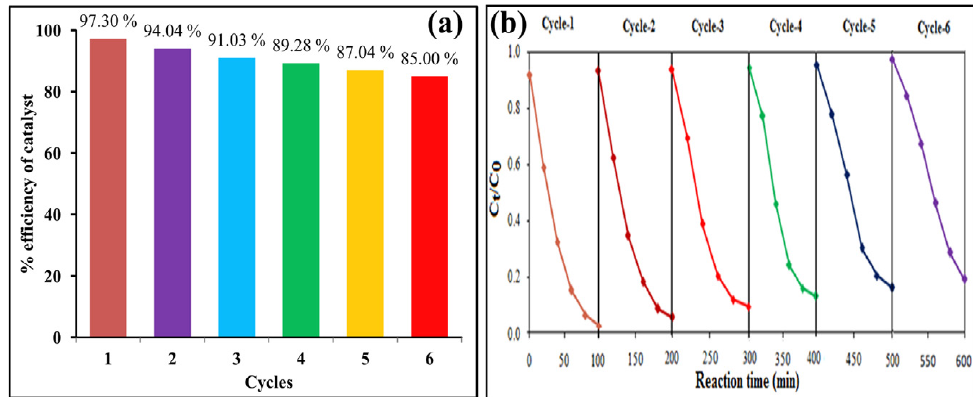
Fig.11. The efficiency of ZnO/CuO nanocomposites over continuous use in different